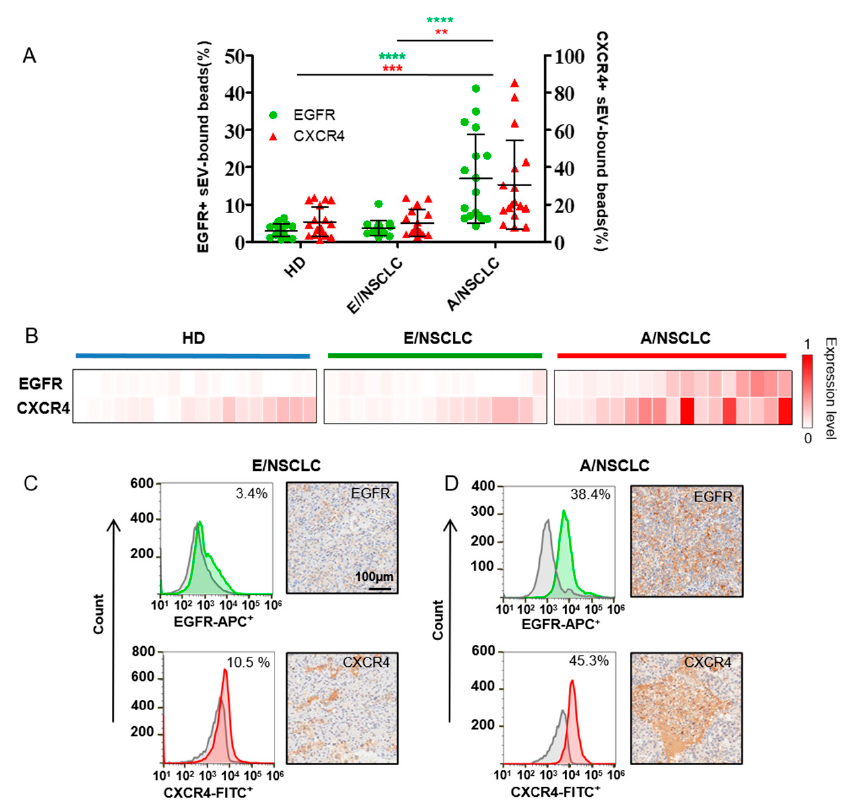
Figure 3. EGFR and CXCR4 expression in serum sEVs act as diagnosis and staging biomarkers of NSCLC. ( A ) Percentage of EGFR+ sEV-bound beads from healthy donors (HDs) (n = 18), early stage NSCLC patients (E/NSCLC) (n = 16) and advanced stage NSCLC patients (A/NSCLC) (n = 17) analyzed by flow cytometry. Data are presented as mean ± S.D. ** p < 0.01, *** p < 0.001, **** p < 0.0001, (Student’s t -test). ( B ) Heatmap of EGFR and CXCR4 expression profiles in sEVs from 18 HDs, 16 E/NSCLC and 17 A/NSCLC patients. Each column represents an individual sample. ( C , D ) The expression of EGFR or CXCR4 in serum sEVs examined by flow cytometry (left) was consistent with that in the patient-matched primary tumor tissue assessed by IHC staining (right) in one E/NSCLC patient ( C ) and one A/NSCLC patient ( D ).